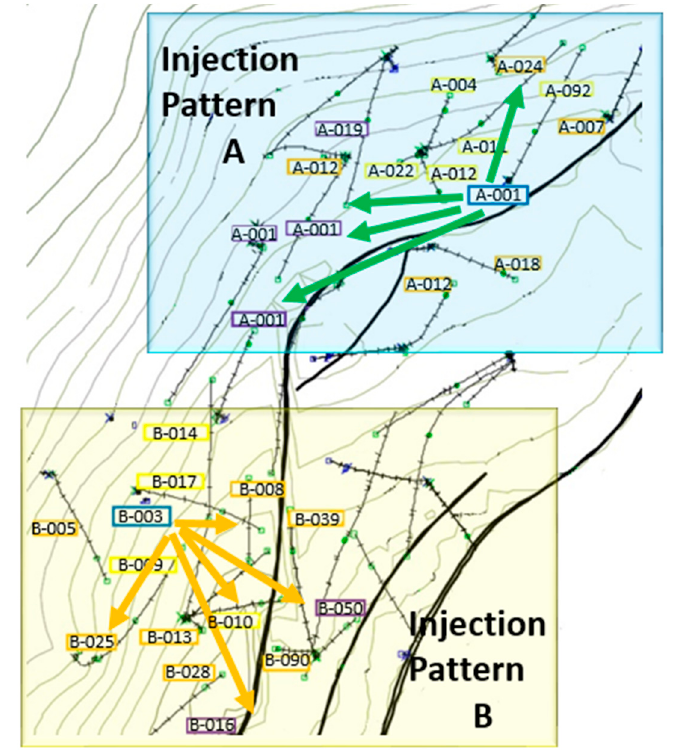
Figure 3. Representation of the flow injection patterns A and B in the Colombian oil field of interest. Table 3. Nanofluid flooding stage injection as a function of the surfactant concentration in the displacement